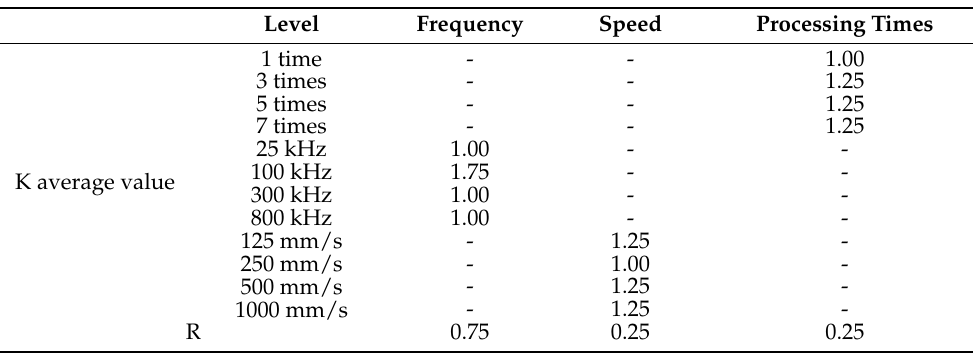
Table 4. Analysis of